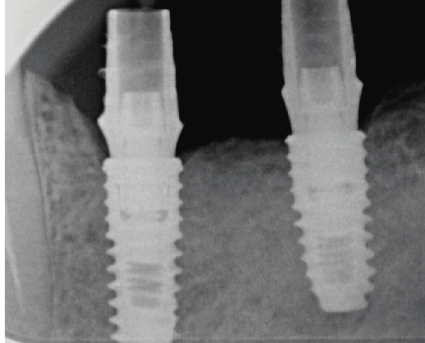
Figure 15: Bone compression during the placement of the pro- visional platform switching system on the implant.